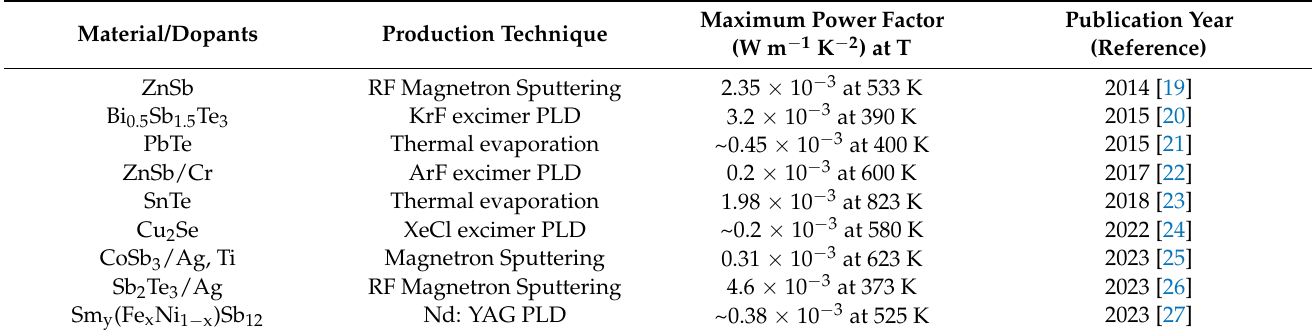
Table 1. List of the most recent published works related to the production of thermoelectric nanos- tructured thin films, displaying material and dopants, technique, power factor at the temperature T, which maximizes the value, and year of